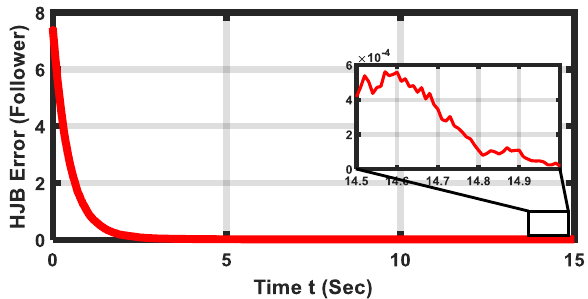
Figure 7. HJB equation error of follower 1 in group 1.